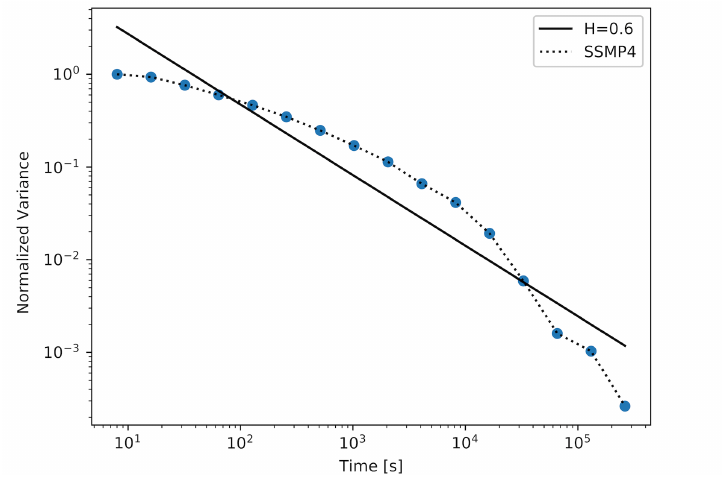
Figure 1. The aggregate variance of the sample in several time scales with the SSMP model, n = 4.